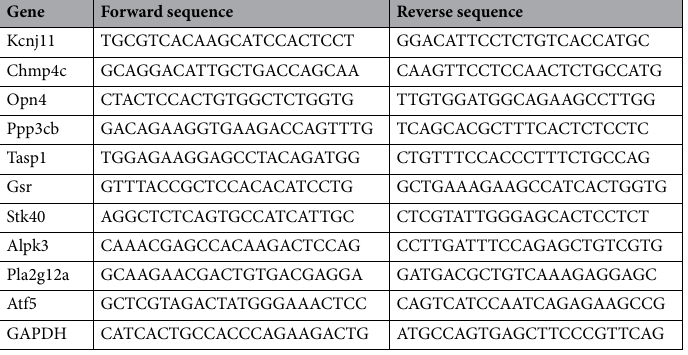
Table 6. Primers used in